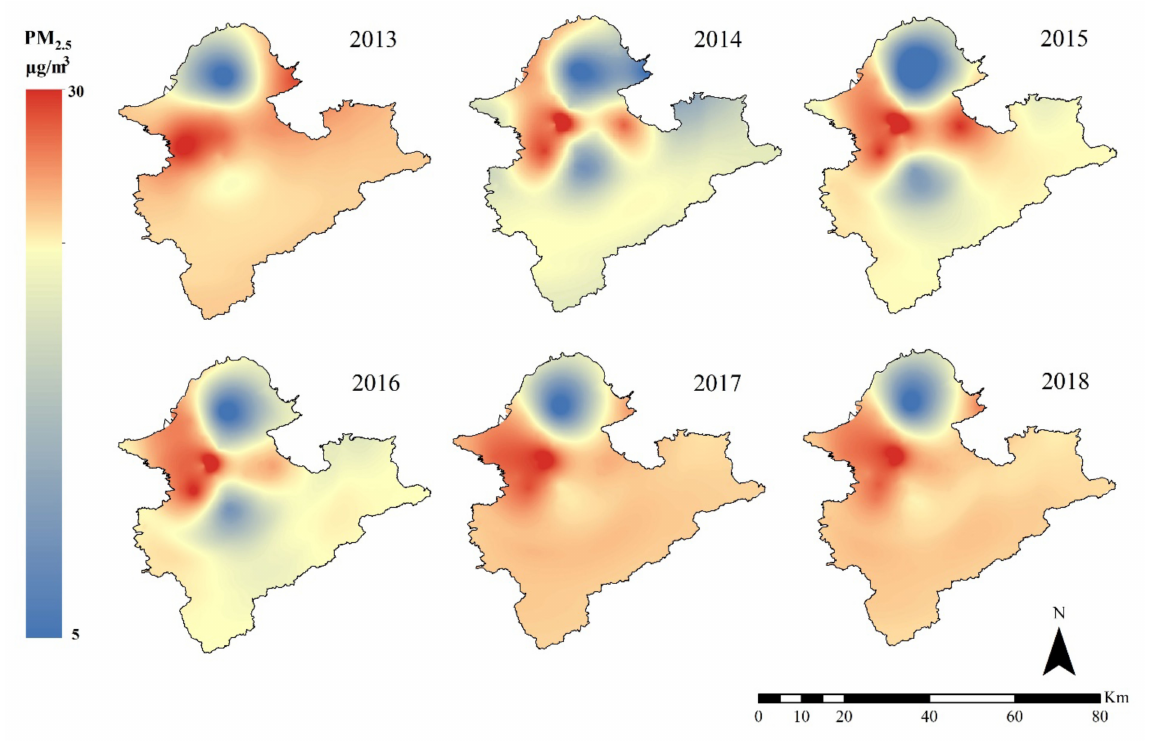
Figure 10. Prediction maps of the spatial–temporal variability of PM 2.5 concentration using the developed